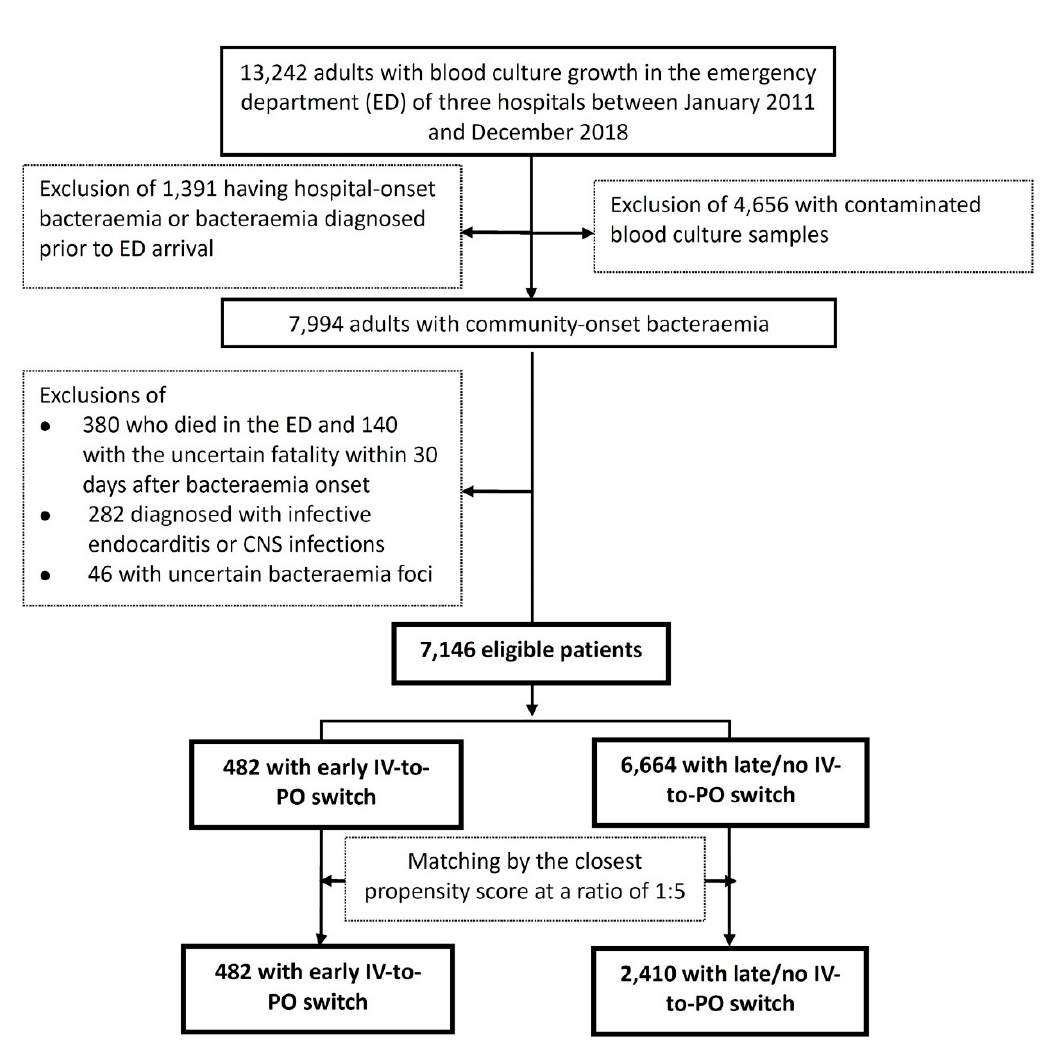
Figure 1. Flowchart of patient selections. CNS = central nerve system; ED = emergency department; MEDS = Mortality in Emergency Department Sepsis.